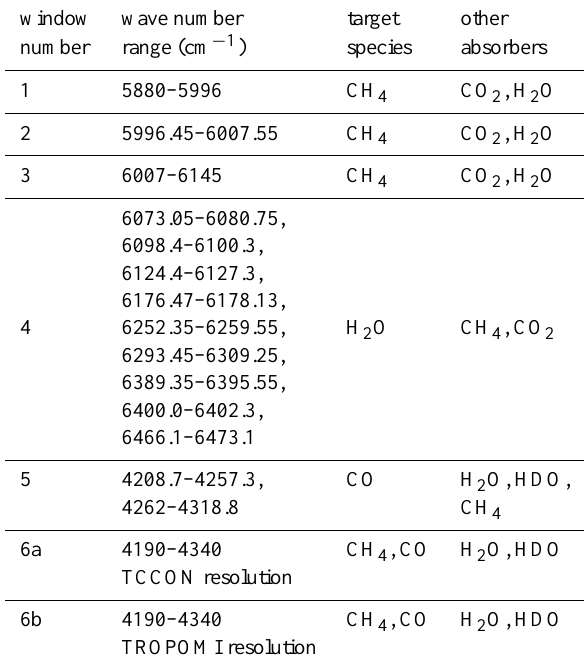
Table 1. Overview of spectral ranges used for